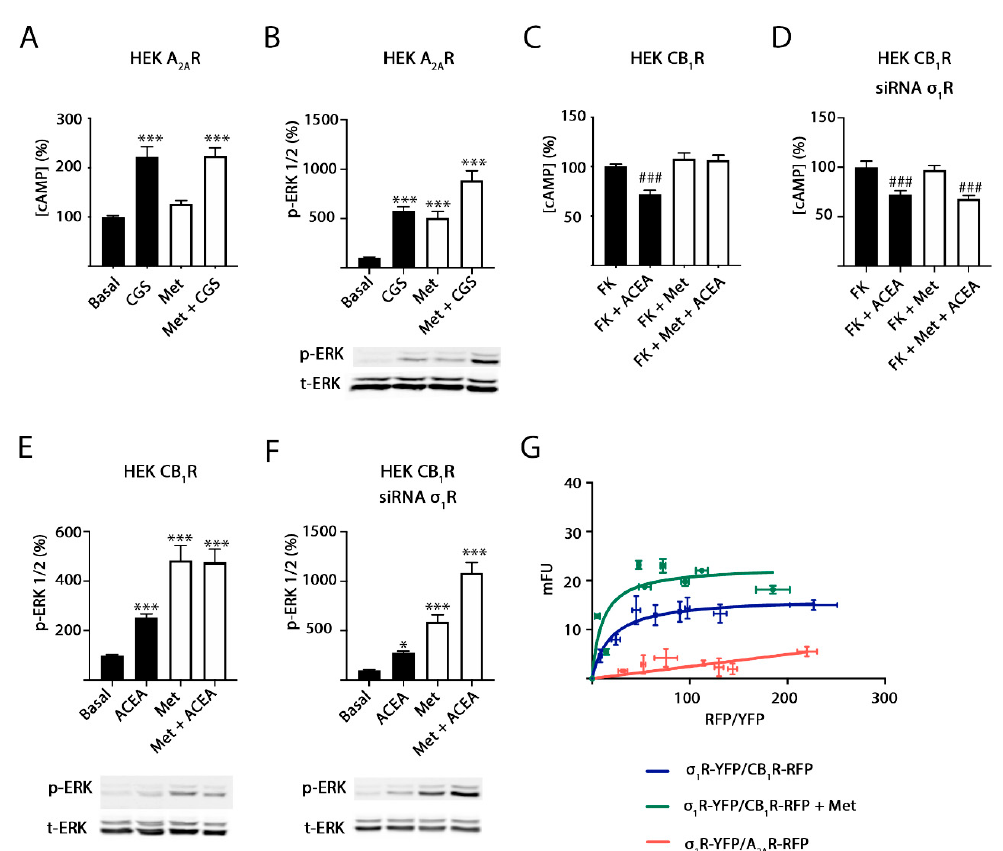
Figure 4. σ 1 R involvement in methamphetamine effects on A 2A and CB 1 receptors. HEK-293T cells transfected with cDNAs coding for A 2A R (0.5 μ g) ( A , B ) or for CB 1 R (0.6 μ g) ( C – F ) in the absence ( A – C , E ) or presence ( D , F ) of siRNA for σ 1 R (3 μ g) to silence σ 1 R were stimulated with 1 μ M methamphetamine (Met, white bars) or vehicle (black bars) for 30 min. Cells were treated with 100 nM of the A 2A R agonist CGS 21,680 (CGS) ( A , B ) or with 200 nM of the CB 1 R agonist, ACEA ( C – F ). 0.5 μ M of forskolin (FK) was used to determine Gi coupling to the CB 1 R. Then, cAMP levels ( A , C , D ) and ERK1/2 phosphorylation ( B , E , F ) were determined and expressed as percentage over basal or, in the case of cAMP in CB 2 R-expressing cells, over forskolin treatment. Values are the mean ± SEM ( n = 5, in triplicates). One-way ANOVA followed by Bonferroni multiple comparison post hoc test showed a significant effect (* p < 0.05, *** p < 0.001 vs. basal condition, ### p < 0.001 versus FK condition). In ( B , E , F ), a representative Western blot is shown (bottom). In G, FRET experiments were performed in HEK-293T cells transfected with 0.25 μ g of cDNA for σ 1 R-YFP and increasing amounts of cDNA for CB 1 R-RFP (0.2 μ g to 2 μ g) or for A 2A R-RFP (0.1 μ g to 1.5 μ g). When indicated cells were pretreated with 1 μ M methamphetamine. Results were grouped by amount of FRET acceptor. p -ERK indicates phosphorylated ERKs, t-ERK indicates total ERKs.